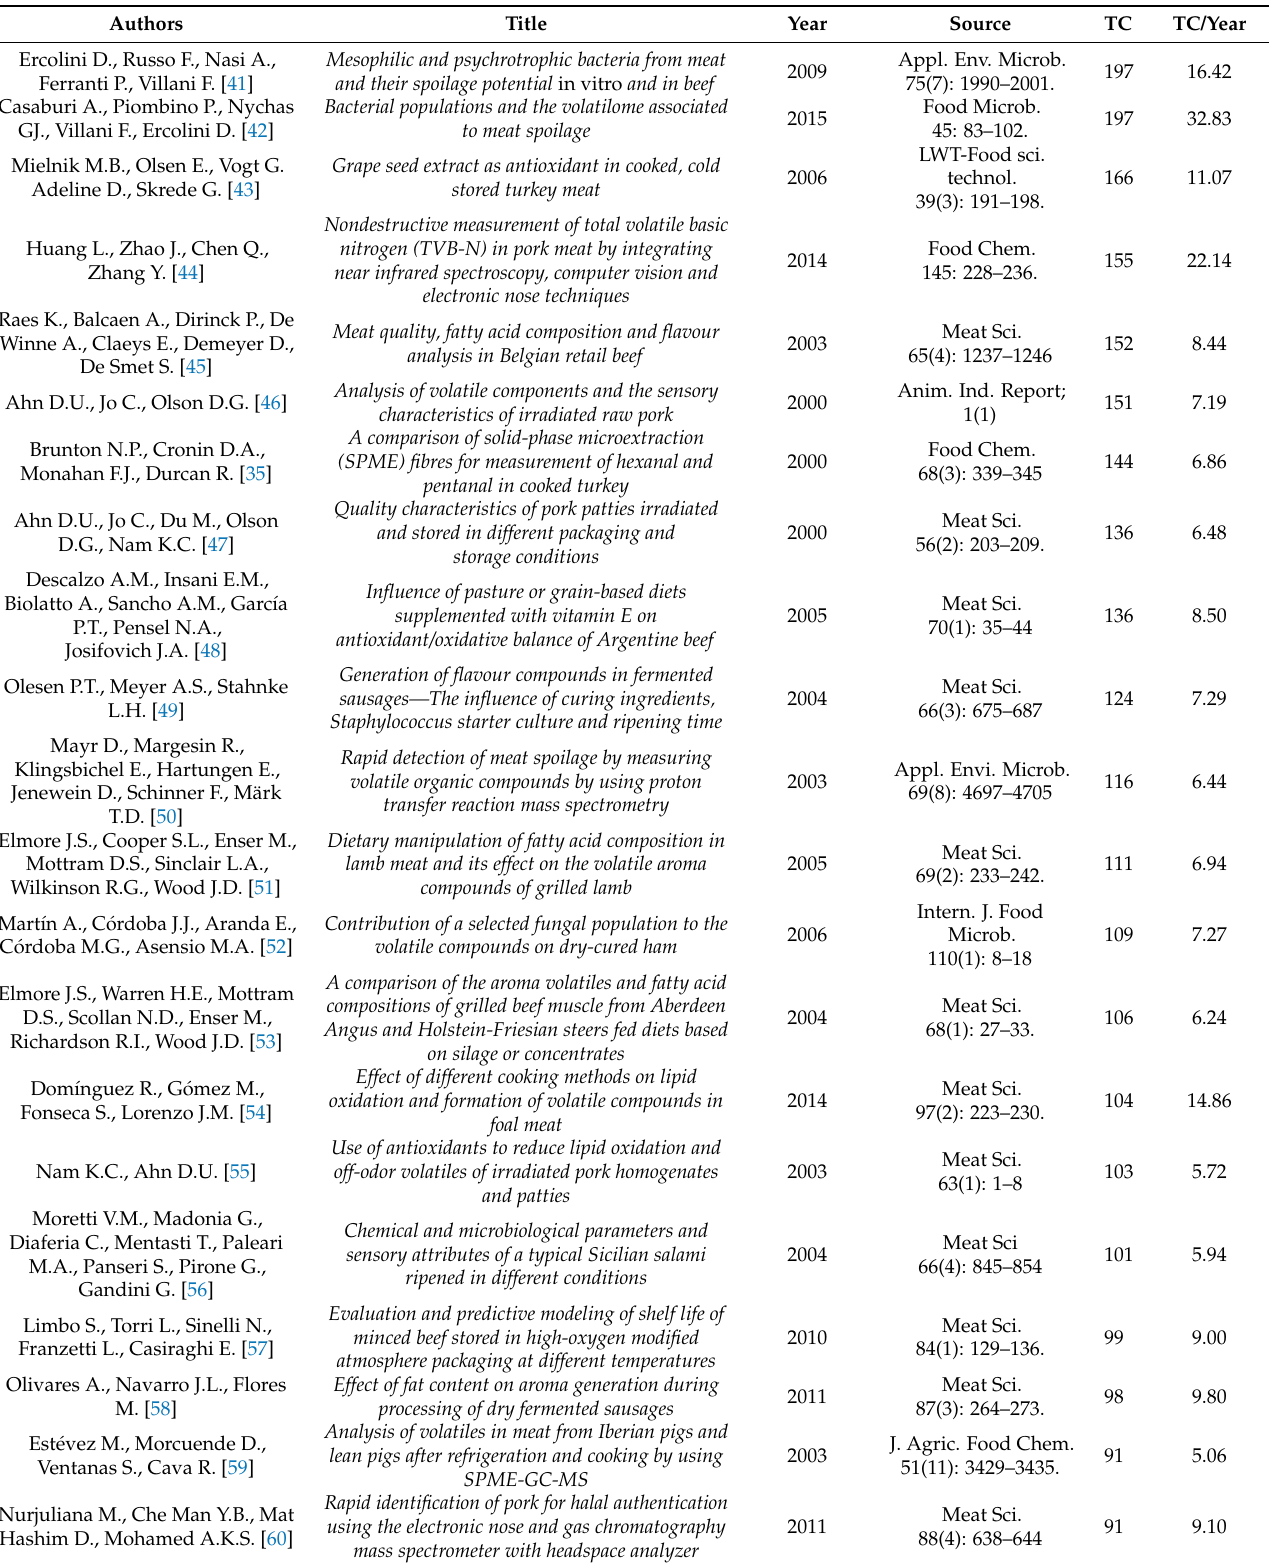
Table 3. The top 25 most cited articles, with authors, sources, total citations (TC) and citations per year